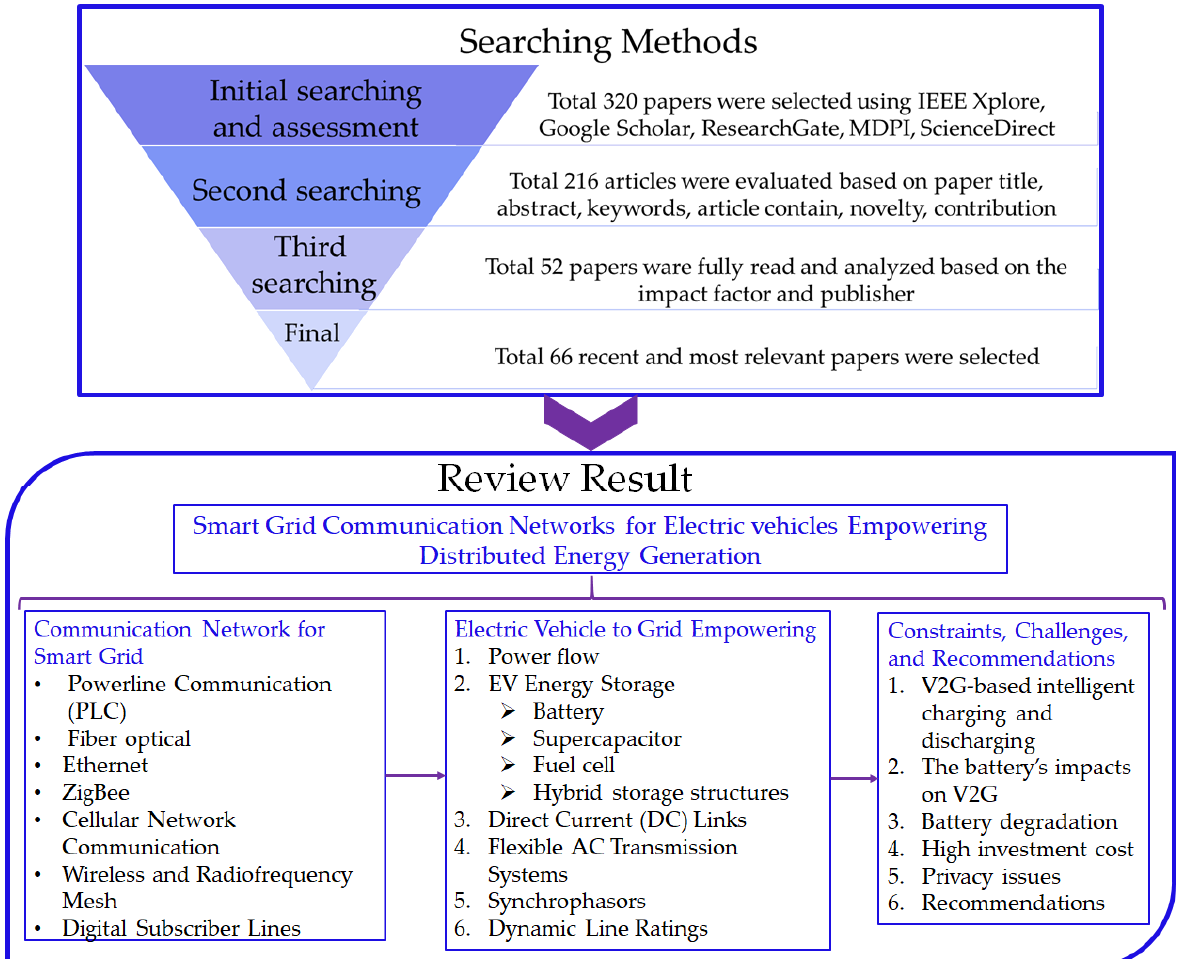
Figure 1. Schematic diagram of reviewing methodology and the funding result of the review.